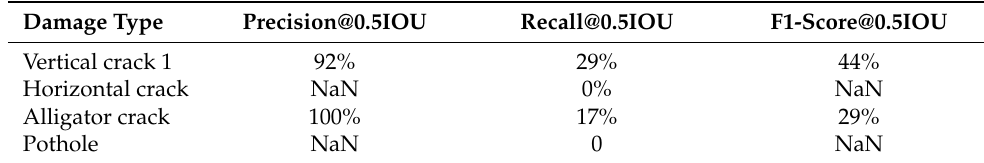
Table 11. Precision and recall Model 6.